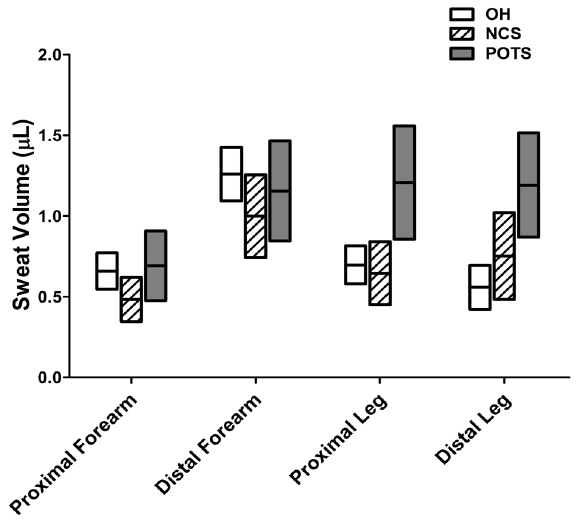
Figure 4. The quantitative sudomotor axon reflex test results according to body site. Postural orthostatic tachycardia syndrome (POTS) patients had greater proximal leg sweat volume (1.21 6 0.97 m L) than OH ( p =0.001) and NCS ( p =0.006) patients. In addition, patients with POTS had greater distal leg sweat volume (1.19 6 0.85 m L) than OH patients ( p , 0.001). No difference in proximal and distal leg sweat volume between OH and NCS patients was observed. No difference in proximal and distal forearm sweat volume was found between groups. The top and bottom borders of the boxes represent the upper and lower limits of the 95% CI range, respectively. The horizontal lines in the middle represent the mean value.